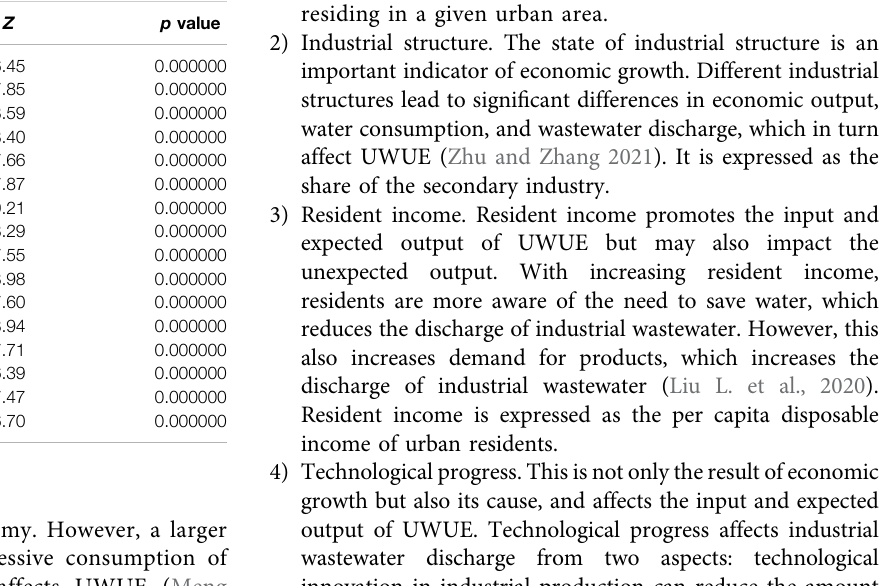
Frontiers in Environmental Science |